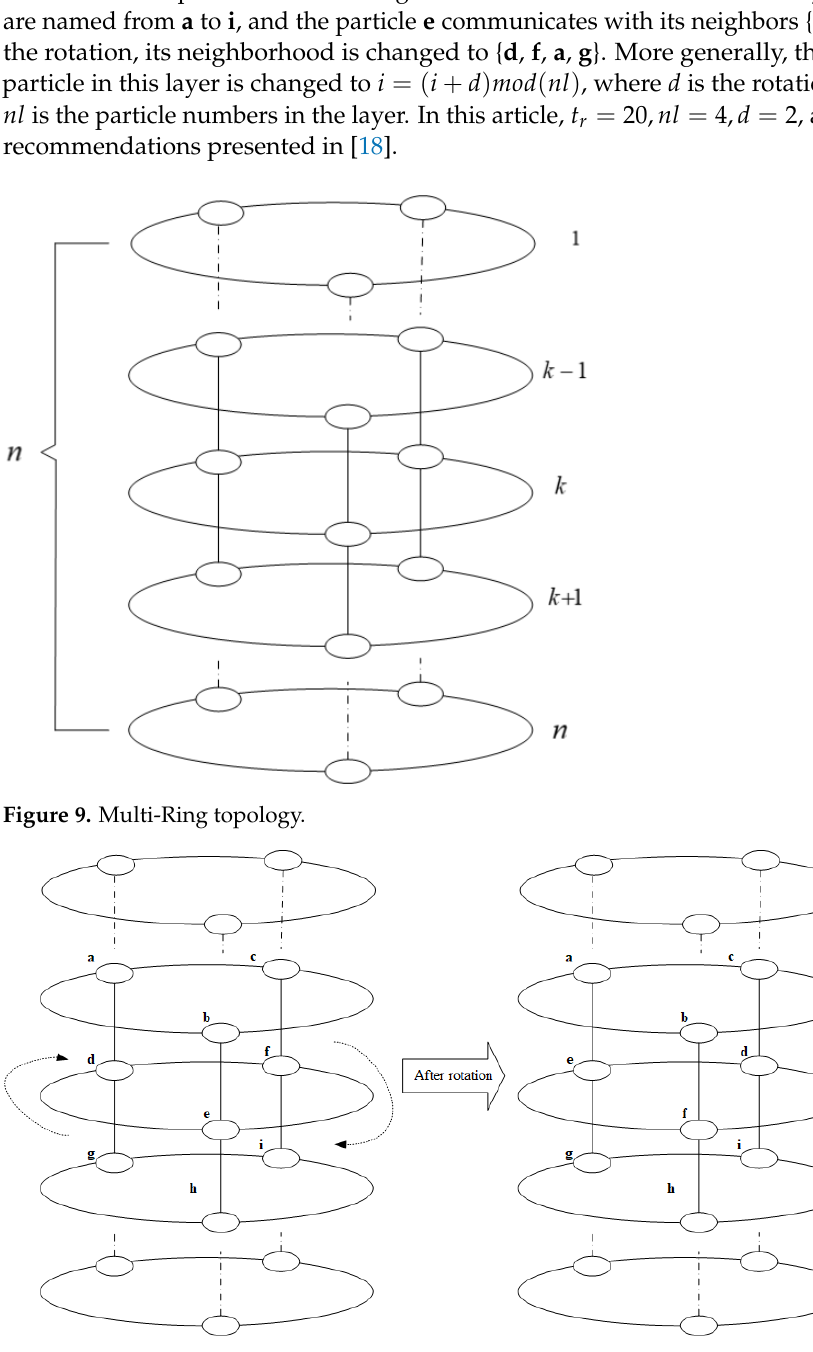
Figure 10. Rotation skill